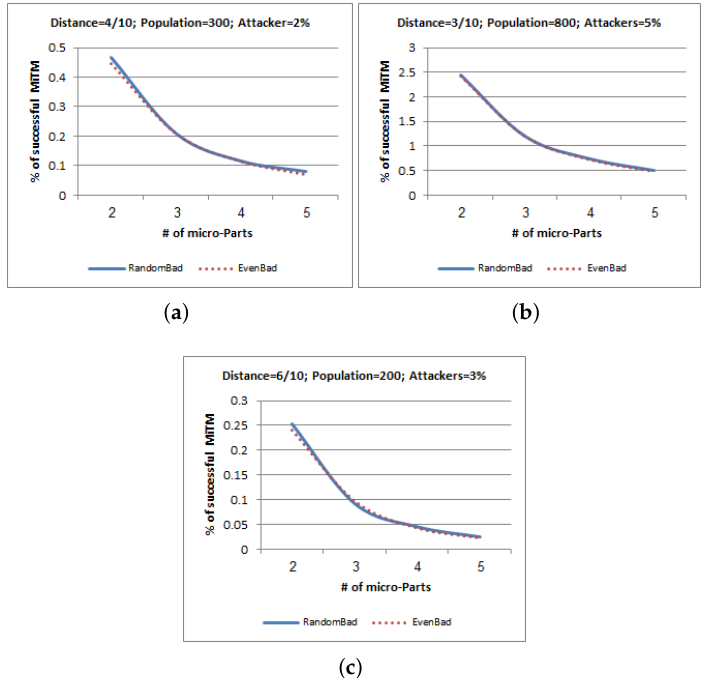
Figure 4. Fluctuating micro-KE parts. ( a ) Distance = 4/10; Population = 300; Attackers = 2%. ( b ) Distance = 3/10; Population = 800; Attackers = 5%. ( c ) Distance = 6/10; Population = 200; Attackers =